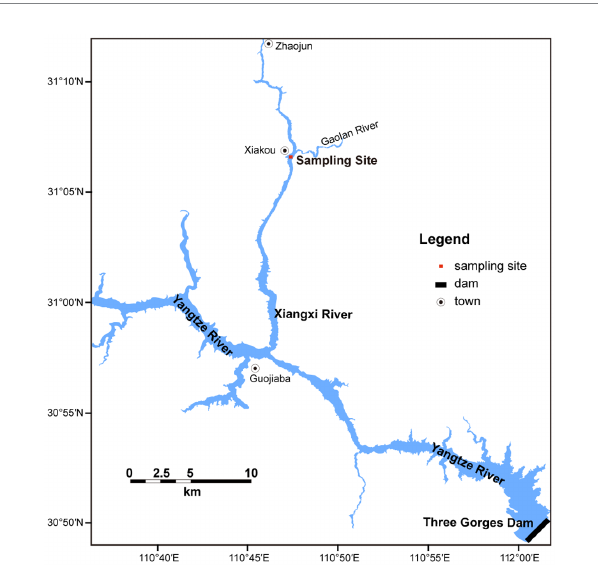
FIGURE 1 Location of the sampling site in Xiangxi Bay of Three Gorges